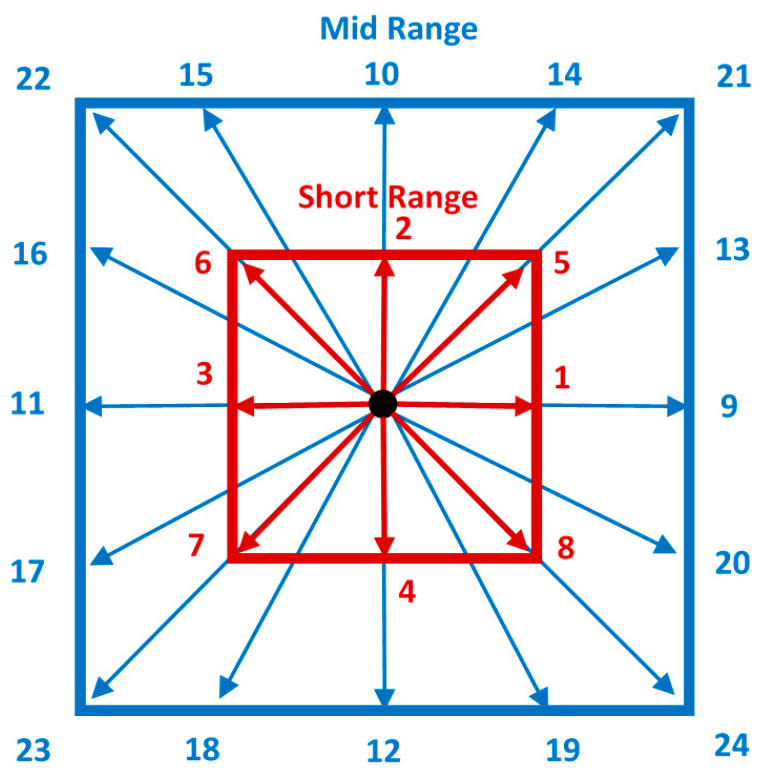
Figure 1. D2Q9 Lattice for short range nodes (red only). D2Q25 Lattice for short- and mid-range nodes (red and blue).